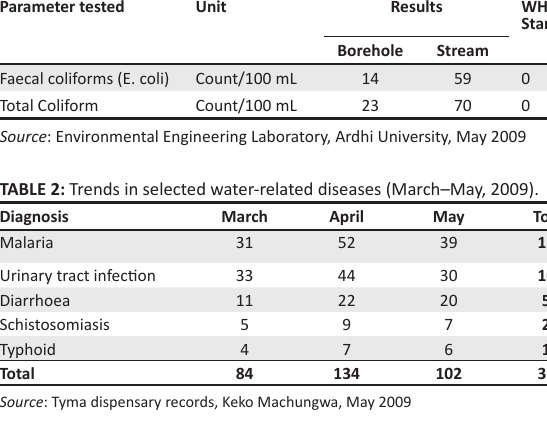
FIGURE 5 : Waterlogging (a) and blocked accessibility (b) to houses.